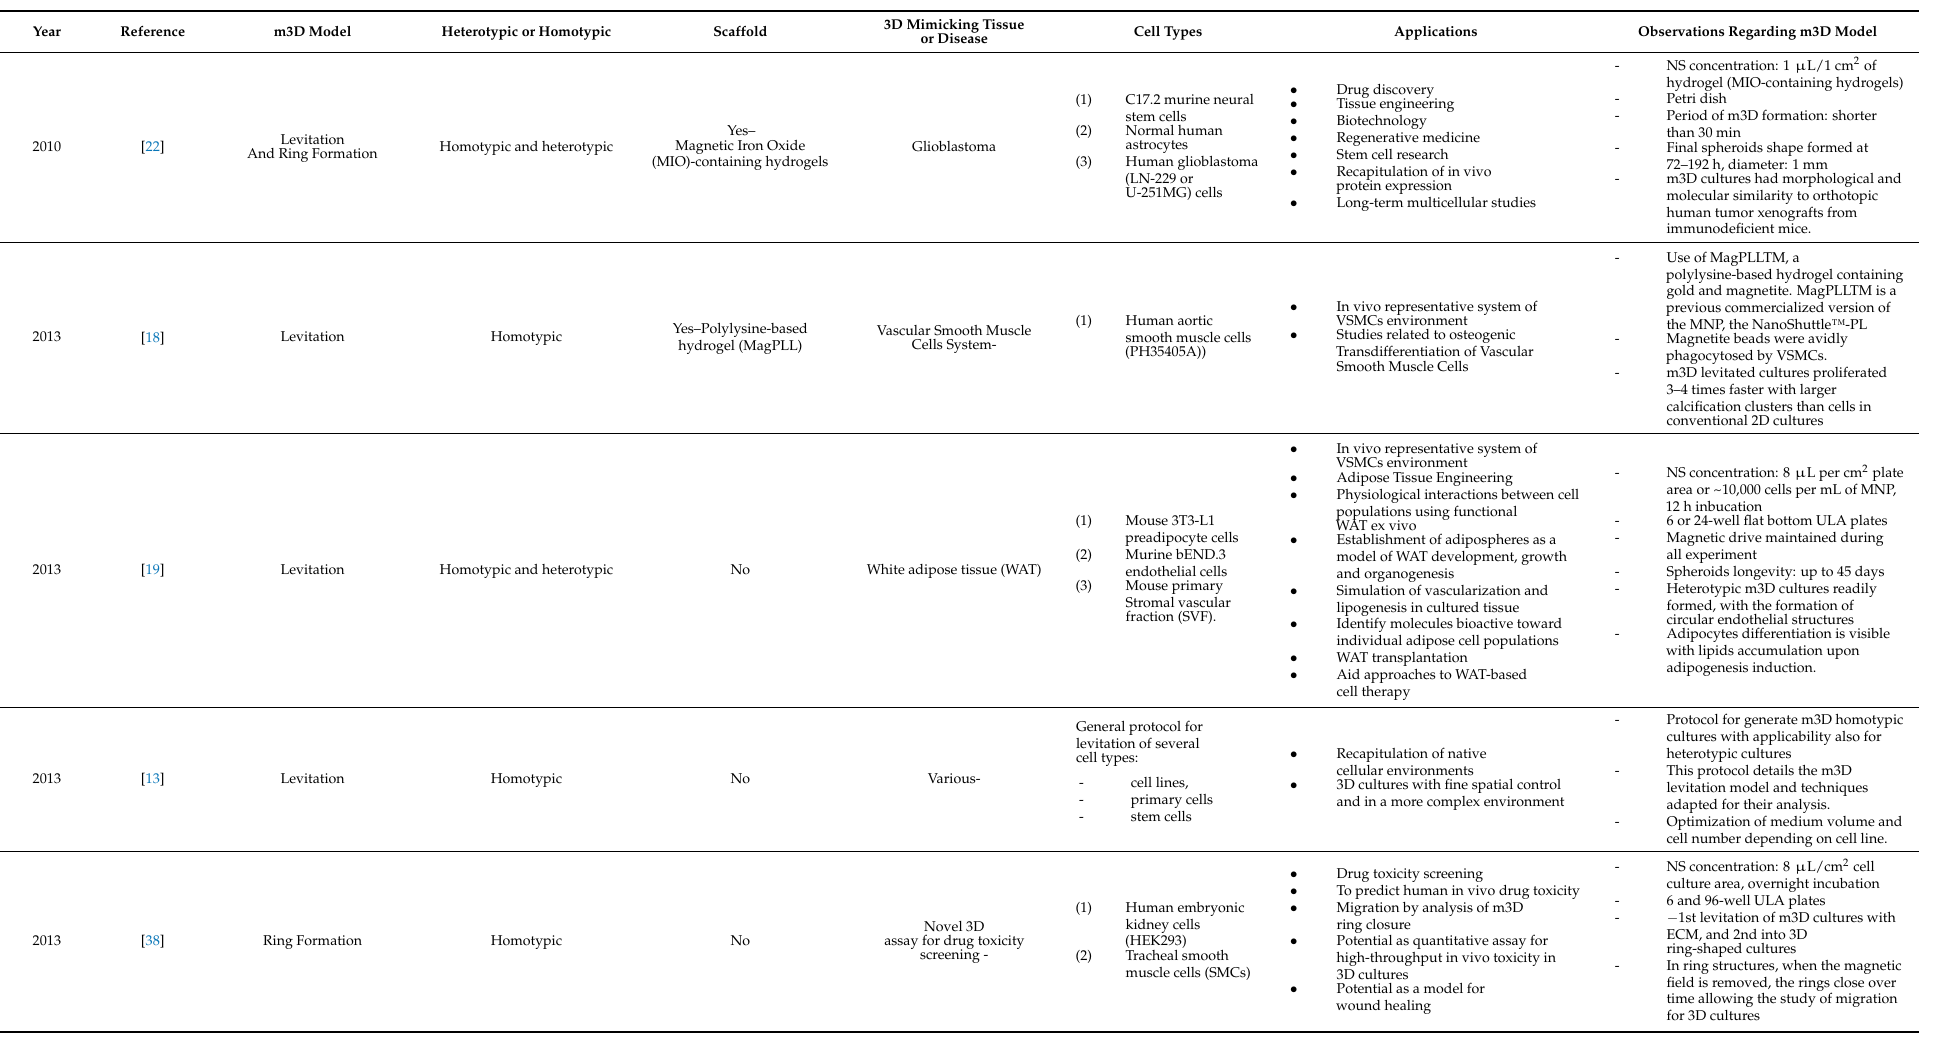
Table A1. Summary table of the studies included in the present systematic review and characteristics of each